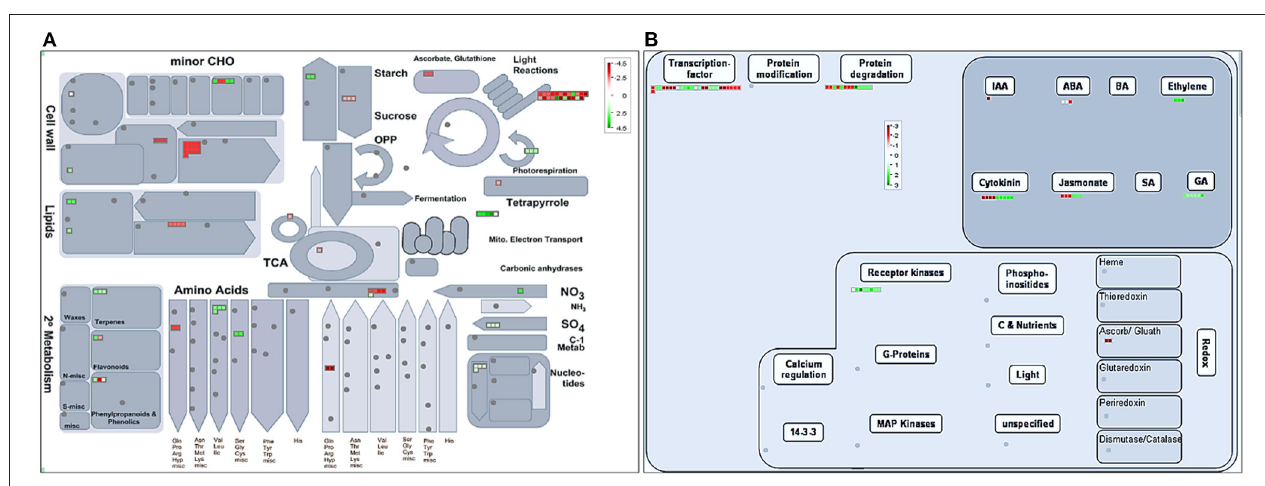
Frontiers in Sustainable Food Systems |